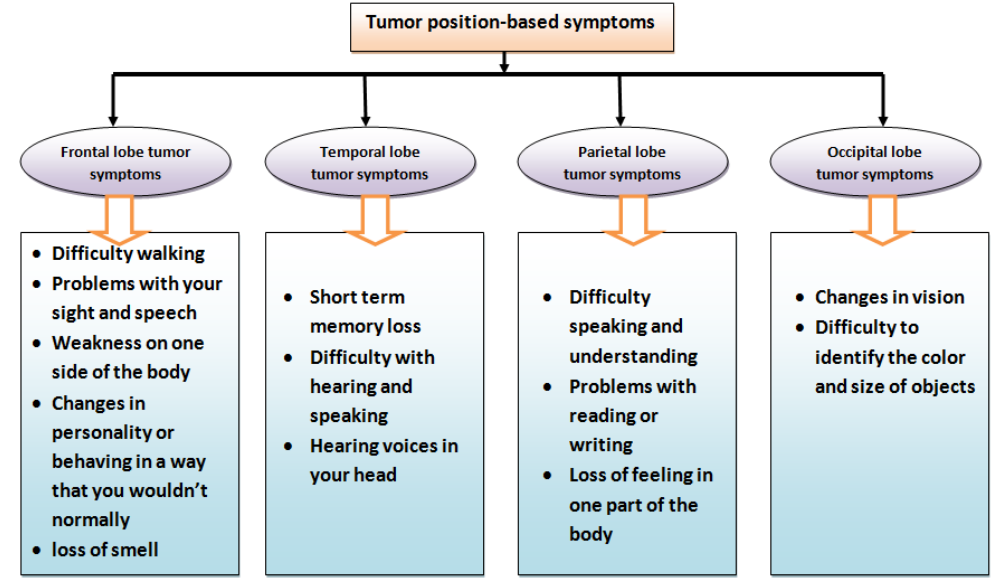
Figure 3. Classification of tumour location-based symptoms (source: